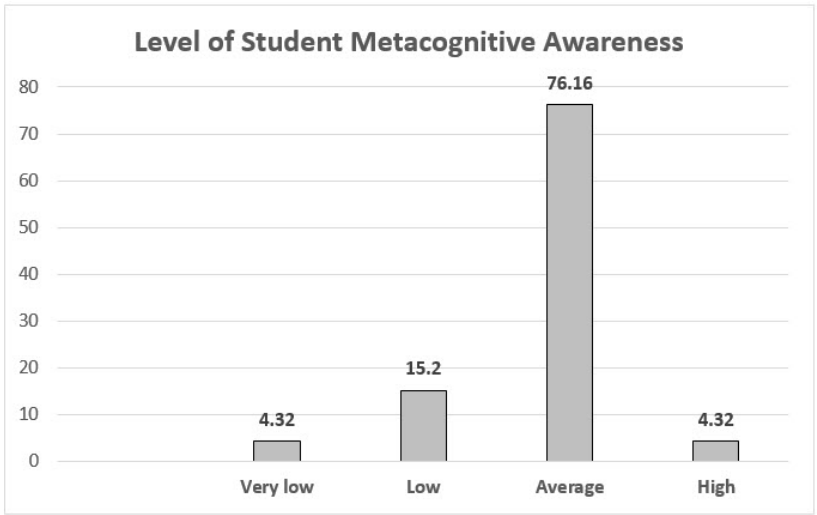
Figure 1. Levels of Student Metacognitive Awareness according to the results of “Metacognitive Awareness Inventory – MAI” (by D. Everson & S. Tobias),